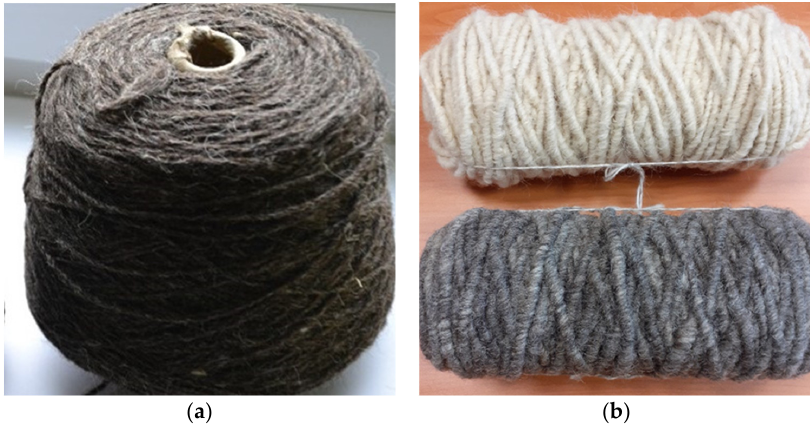
Figure 4. Wool yarns manufactured from mountain sheep wool; ( a ) ring spun; ( b ) core rug.